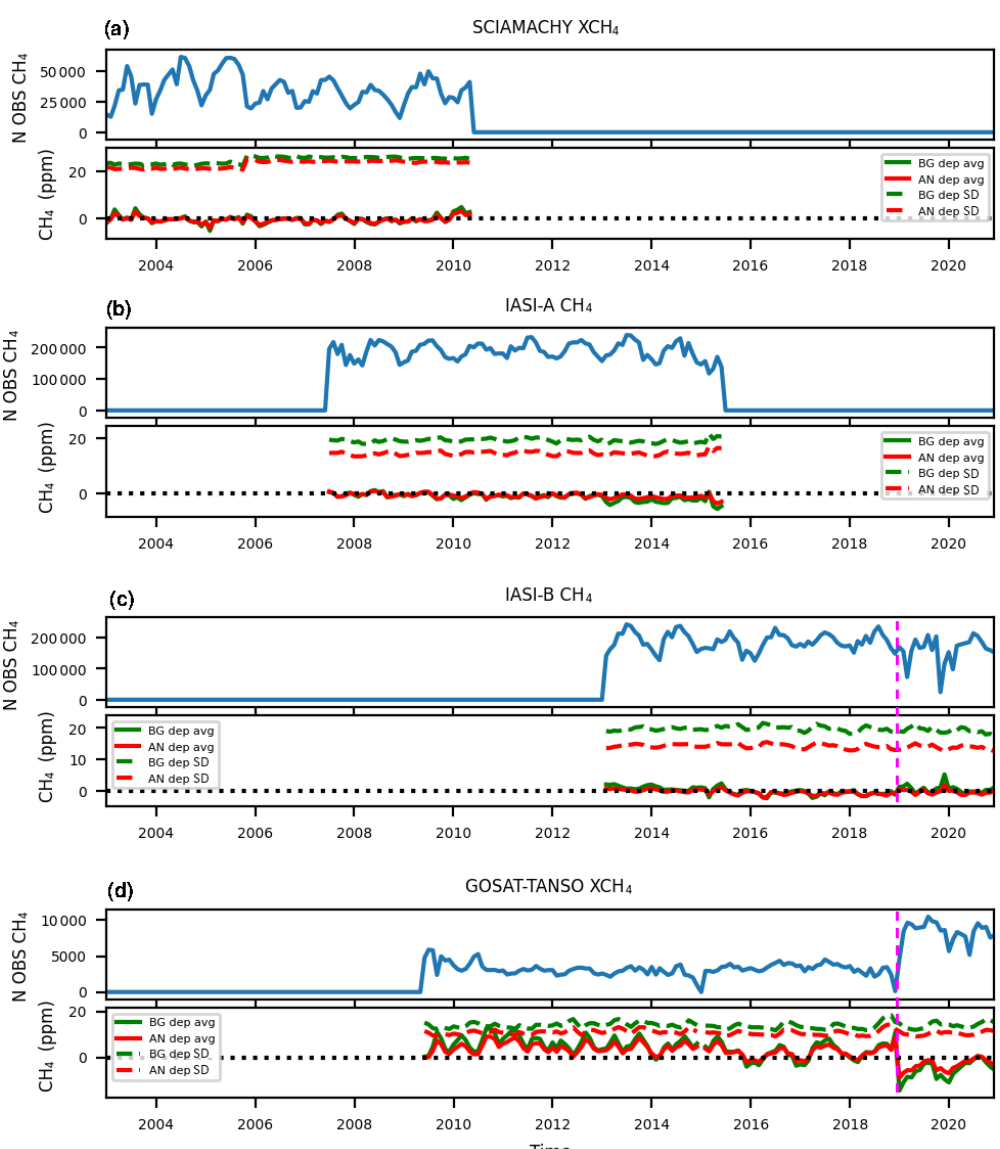
Figure 6. Time series of the global monthly number of XCH 4 satellite data (blue) and monthly mean CH 4 analysis (AN) and model background (BG) departures of the various observations (OBS) assimilated in the reanalysis (AN–OBS and BG–OBS in red and green, respectively; see the legend) for different satellite products. The solid lines show the monthly average of the departures, and the dashed lines show the monthly standard deviations. The dashed magenta line indicates the switch to the near-real-time satellite products. Note that the range of values on the y axis varies depending on the satellite